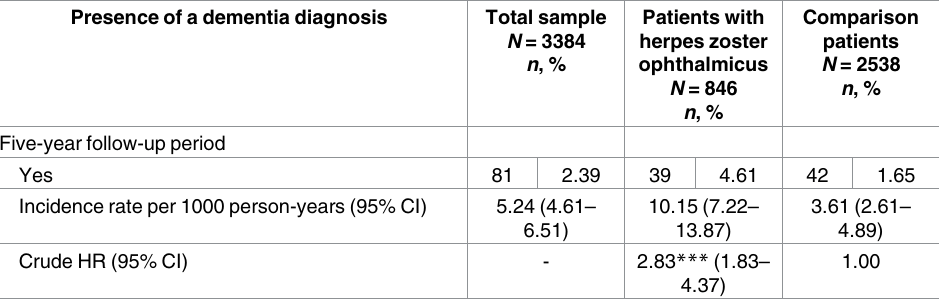
Table 2. Crude hazard ratios (HRs) and 95% confidence intervals (CIs) for dementia among sampled patients during the 5-yearfollow-up